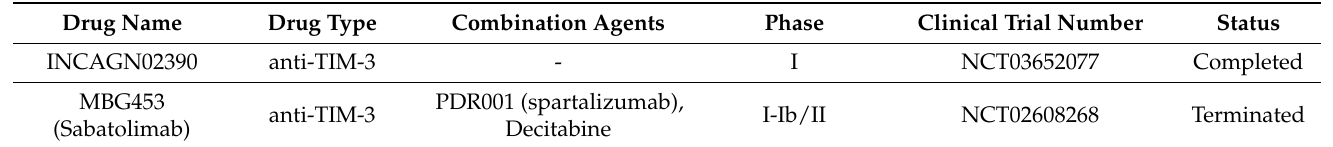
Table 2. Clinical trials showing treatment of ovarian cancer with anti-TIM-3 antibodies (https: //clinicaltrials.gov/, accessed on 27 September